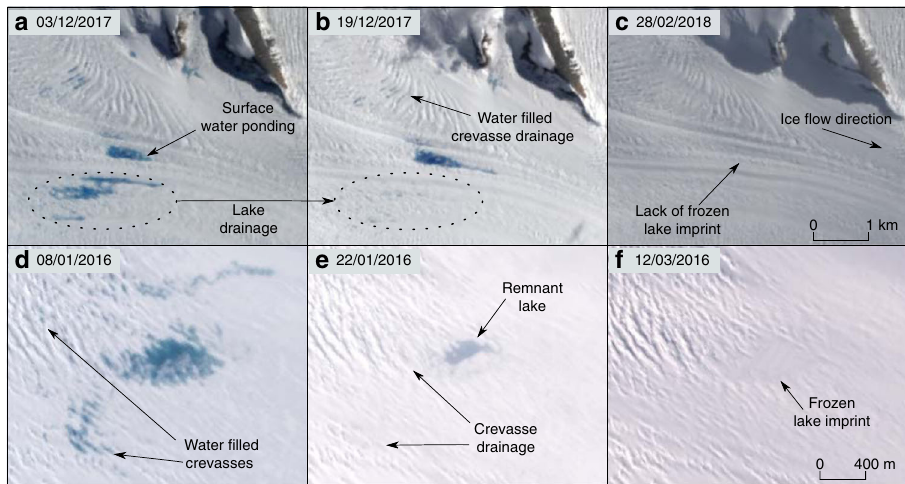
Fig. 5 Satellite images of surface meltwater. a – c Landsat 8 images of ponds and water- fi lled crevasses draining on Hektoria Glacier, location is shown in Supplementary Fig. 9. d , e Sentinel 2 images of a region of potential lake and crevasse meltwater drainage, showing subsequent freezing on Drygalski Glacier. Location is shown in Supplementary Fig. 10